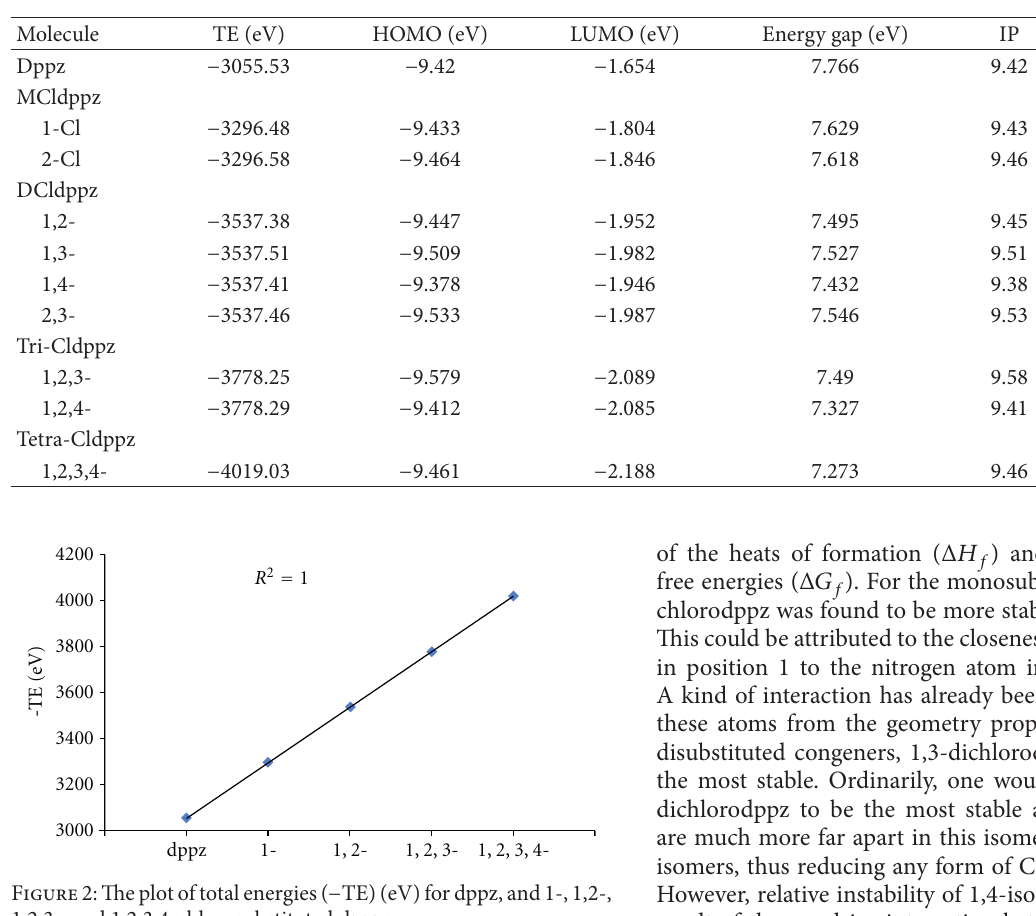
T 3: Electronic properties of the optimized structures.